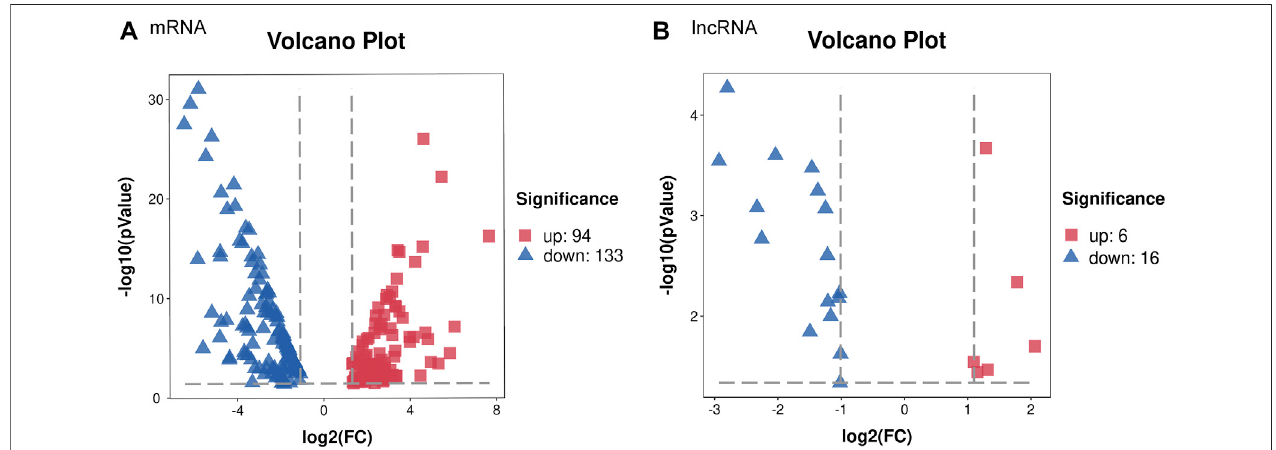
FIGURE 2 | Differentially expressed genes between the iBmp2 fx/fx and iBmp2 ko/ko groups. Our data showed that 94 mRNAs upregulated and 133 mRNAs downregulated in the iBmp2 ko/ko cells compared to those in the iBmp2 fx/fx cells (A) . Meanwhile, 6 lncRNAs upregulated and 16 lncRNAs downregulated (|log2FC| ≥ 1; Qvalue < (cid:1) 0.05) in the iBmp2 ko/ko cells (B) . Red represents upregulated DEG, blue represents downregulated DEG.